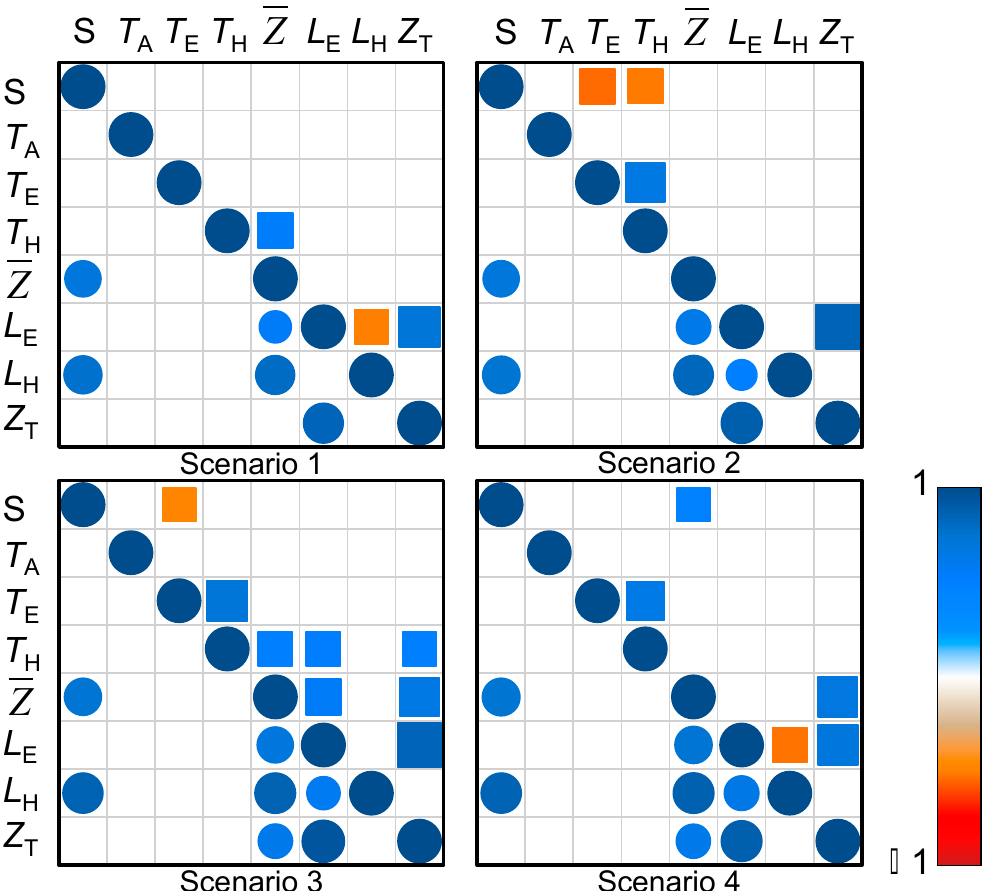
Figure 8. Correlation matrices (Spearman’s ρ ) for climate warming scenarios. Only significant coefficients are shown ( α = 0.05). Circles indicate original values for that warming scenario; squares indicate differences in the values of a given variable between the given warming scenario and the reference run with no change. Variables are annual means and include stability (S); temperature of the air ( T A ), epilimnion ( T E ), and hypolimnion ( T H ); mean reservoir depth ( Z ); thicknesses of the epilimnion ( L E ) and hypolimnion ( L H ); and depth of the thermocline ( Z T ). Data from low water years (2002 to 2004) were excluded given that the study reservoir did not stratify then.